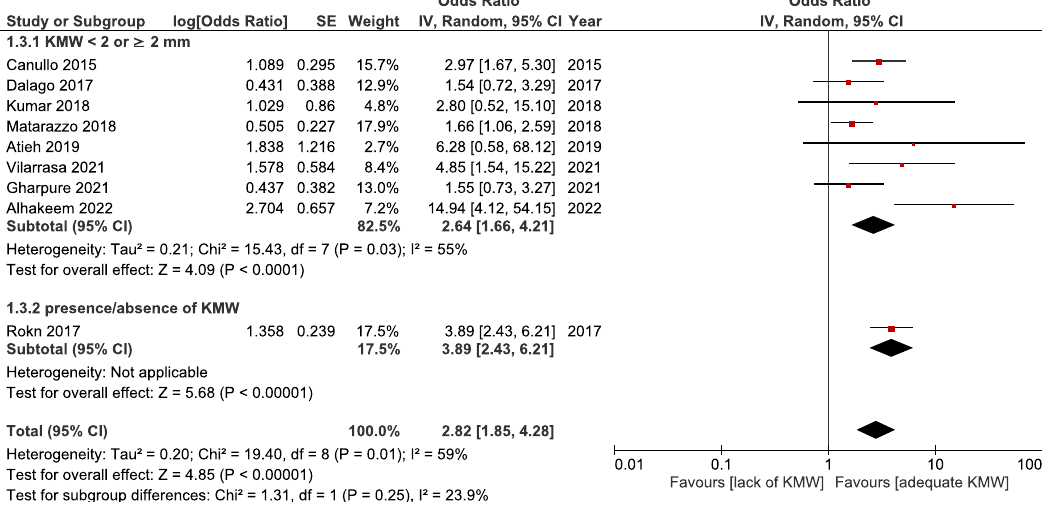
Figure 4. Result of the meta-analysis, including studies with fixed prosthesis only.